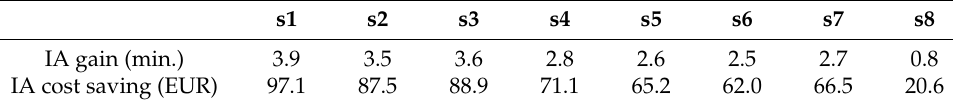
Table 9. Cost savings for IAs in all solutions.